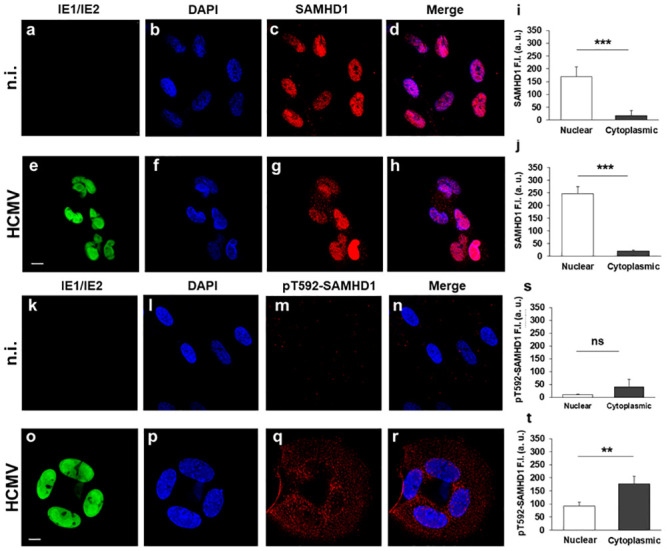
SAMHD1 intracellular localization in uninfected and HCMV-infected cells.HFFs were not infected (n.i.) or infected with AD169 at an MOI of 1 for 3 days. Stainings were then performed using primary antibodies directed against total (c and g) or pT592-SAMHD1 (m and q), followed by Alexa-Fluor 594 conjugated goat anti-rabbit (red), together with IE1/IE2 viral antigens followed by Alexa-Fluor 488 conjugated goat anti-mouse (a, e, k, o) (green) antibodies. Nuclei were stained with DAPI (b, f, l, p) (blue). Confocal images were acquired with a zoom 2 and are shown as single optical slice from one representative experiment out of six. An overlay of blue/red images (d, h, n, r) is also shown. Scale bar: 10μm. Fluorescence intensity (F.I.) of SAMHD1 (i-j) and p-T592 SAMHD1 staining (s-t) was calculated in the nucleus and cytoplasm of 80 cells randomly acquired from 3 independent experiments, as described in materials and methods. Histograms represent the mean ± SE. Displayed values are millions of a.u. ns, not statistically significant difference; ** p < 0.01; *** p < 0.001.